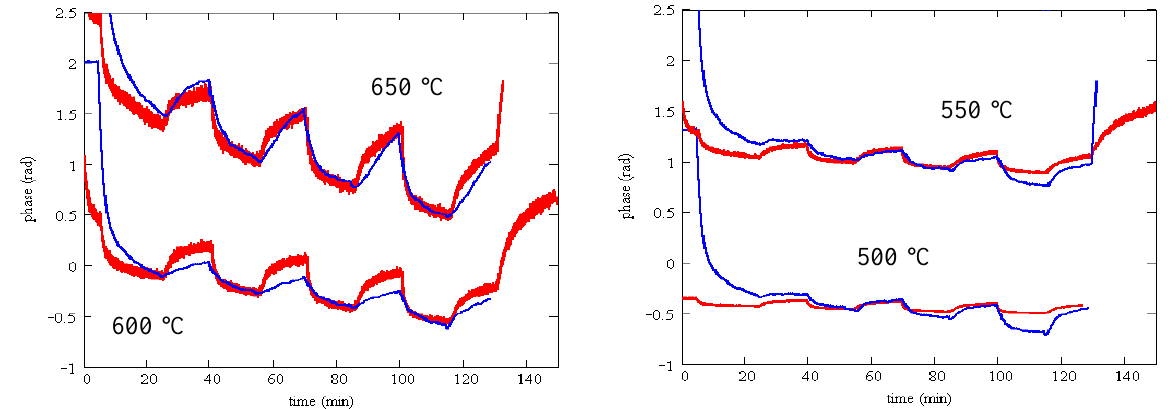
Figure 21. Measured phase changes for SAW device with SnO calculated phase change from measured resistivity